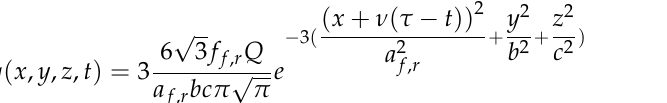
Figure 8. Finite element of the fully adopted mesh for all thermal and mechanical analysis.